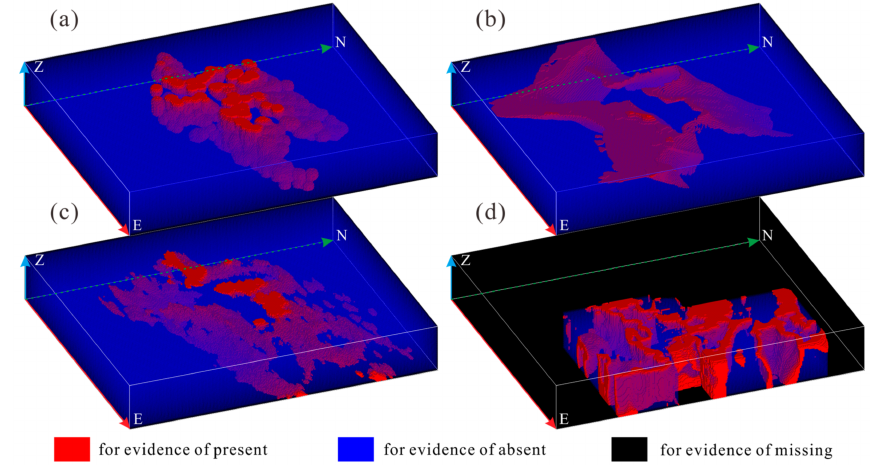
Figure 10. Binary predictive maps for exploration criteria, their present evidences are: ( a ) B, contact buffers (0–200 m) around chosen abnormal areas; ( b ) C, carbonate rocks in T 1 n and T 2 y ; ( c ) V, volume strain field (vsi is more than 0.6%) and ( d ) R, resistivity field ( ρ is between 1000–2000 Ω · m).